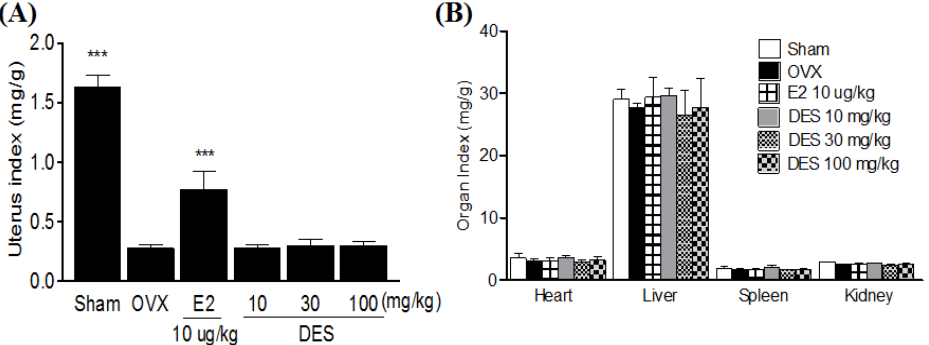
Figure 4. Effects of DES on change in uterus ( A ) and organ index ( B ) in OVX rats. Uterus and organs were dissected, washed with saline, and immediately weight for analysis. Data are mean ± SD values (n = 10 per group). *** p < 0.001, significantly difference from the OVX-control group.